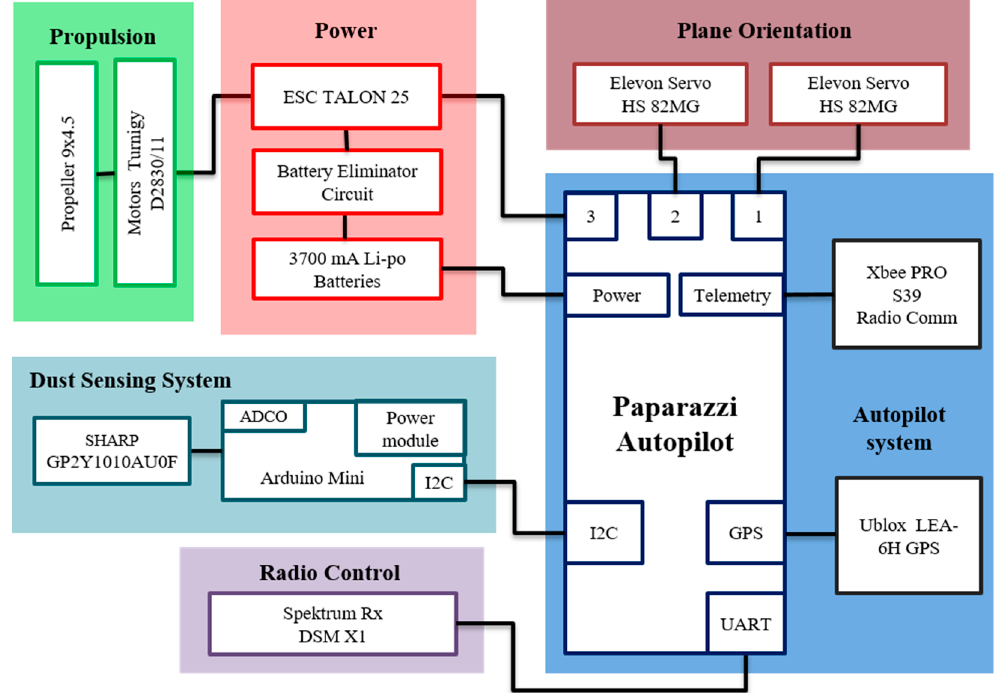
Figure 1. System architecture for the fixed-wing UAV with dust sensor.